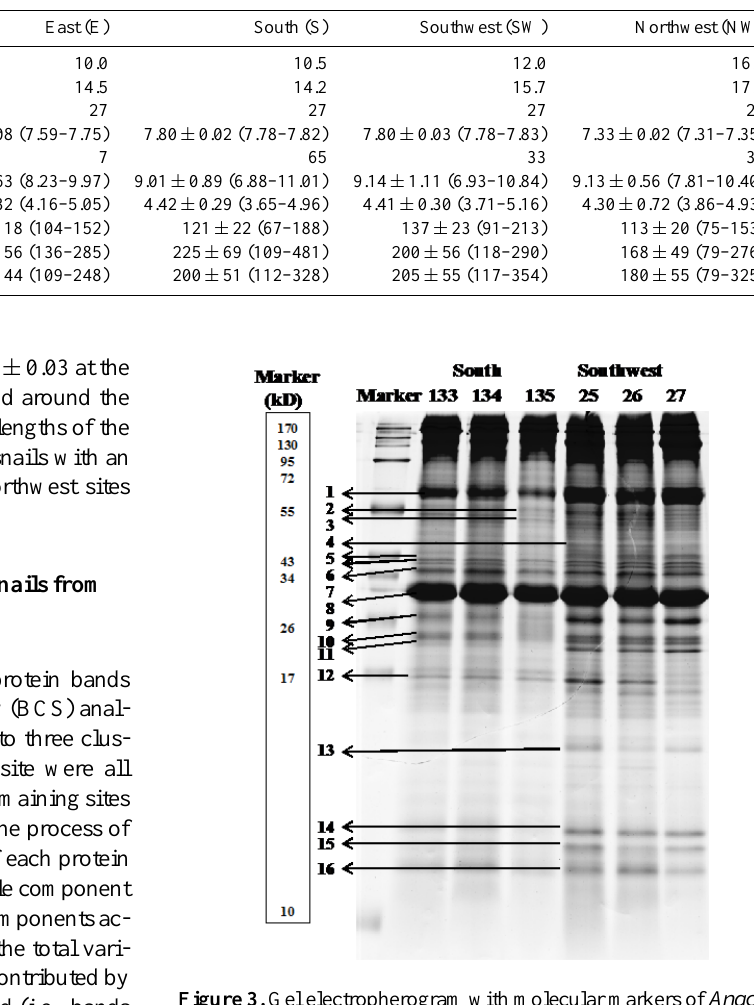
Figure 3. Gel electropherogram with molecular markers of Anachis misera . Number: protein band serial